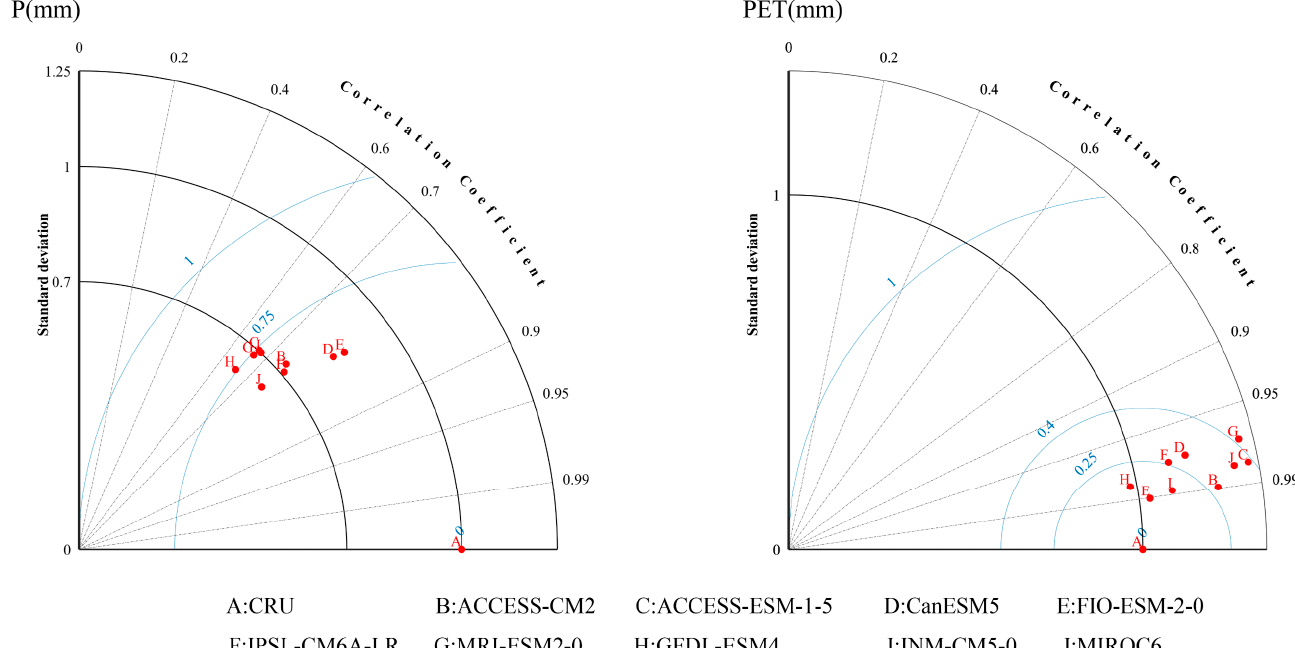
Figure 2. Standardized Taylor diagram showing the model simulation capability of simulated values for nine GCMs from 1960–2014 for observational data of temperature, precipitation, and potential evapotranspiration. (The standard deviation in a Standardized Taylor diagram is the ratio of the standard deviation of the model to the standard deviation of the